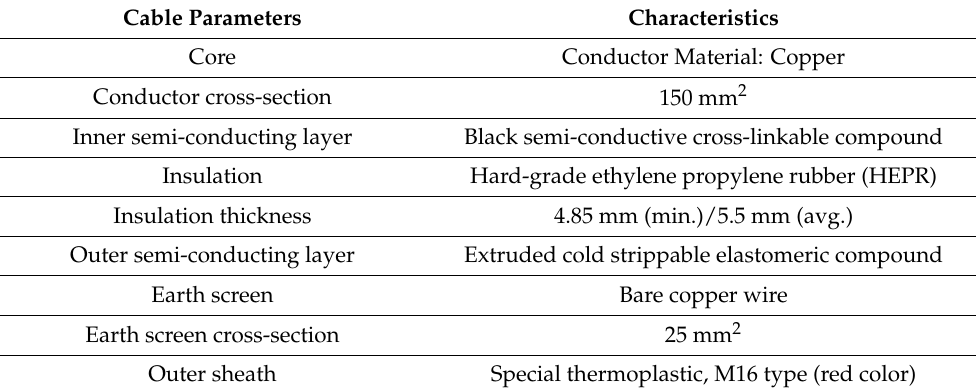
Table 3. Cable composition and characteristics.